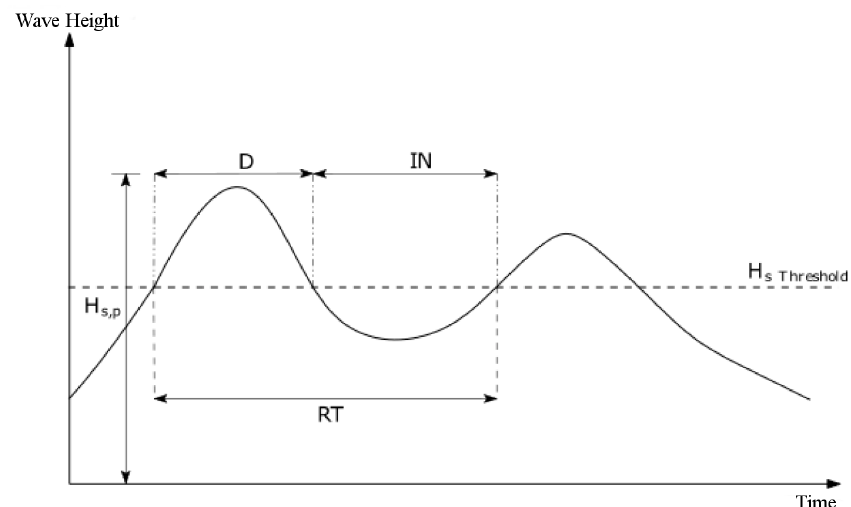
Figure 7. Storm event definition method (following Bennett et al. [42]). D—duration of storm; IN—interval between two storms; H s,p —peak storm wave height; H s Threshold —pre-defined storm threshold; RT — consecutive storm event.